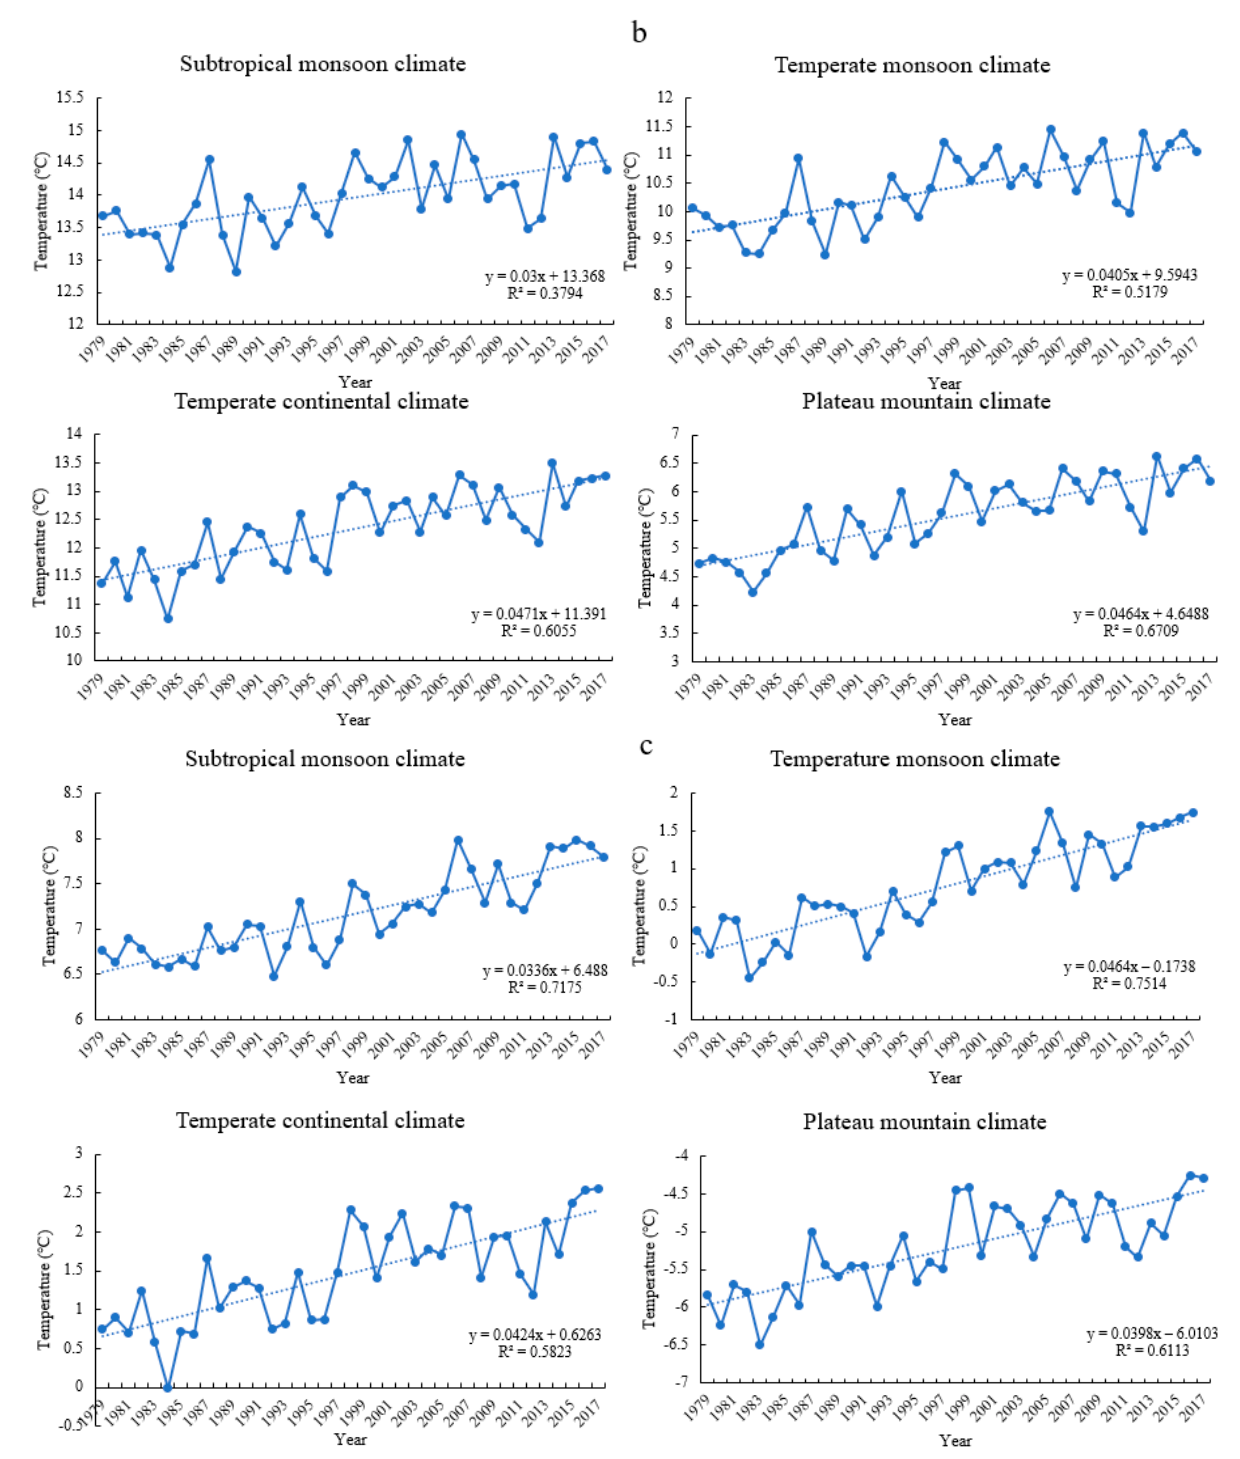
Figure 3. Trends of increasing daily ERA-Interim temperature data for the four different climate zones within Gansu Province during the period 1979–2017. ( a ) Mean temperature. ( b ) Maximum temperature. ( c ) Minimum temperature.